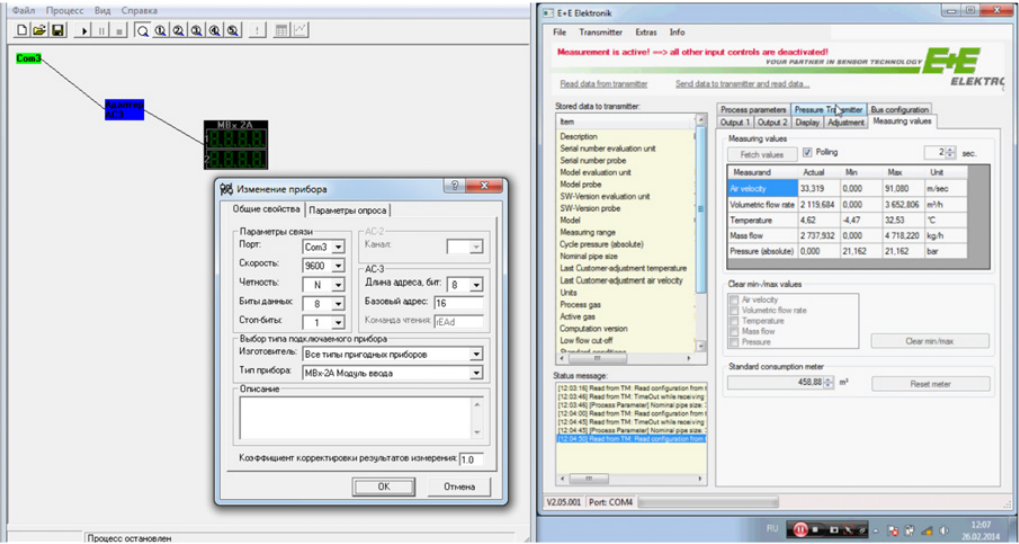
Figure 2. Data Collection